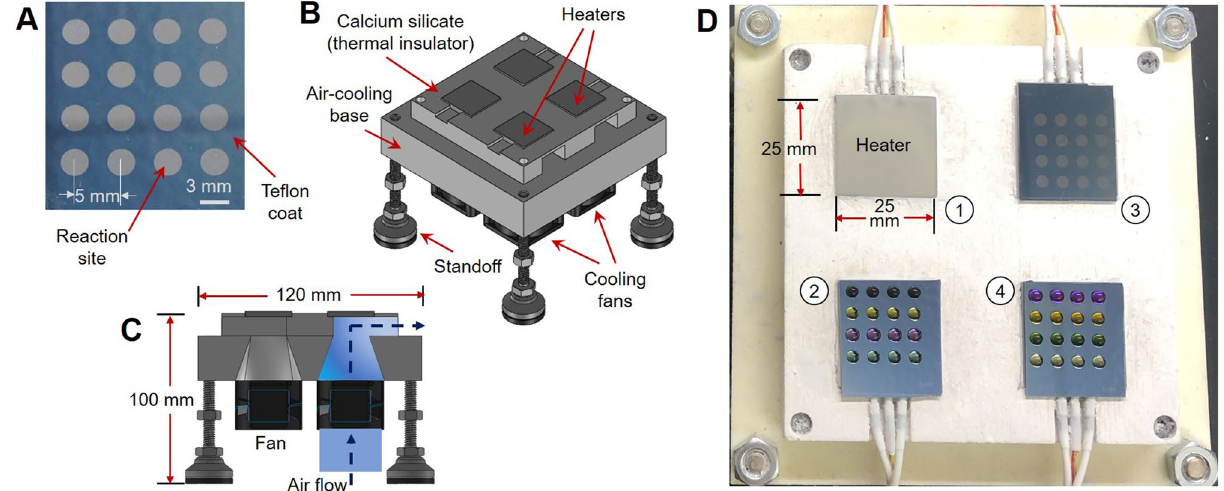
Figure 1. High-throughput reaction apparatus. ( A ) Photograph of multi-reaction chip. ( B ) CAD model showing platform components. ( C ) Cross-section view of the multi-heater platform showing the path of forced- air cooling. ( D ) Photograph of the platform (from above) with multi-reaction chips